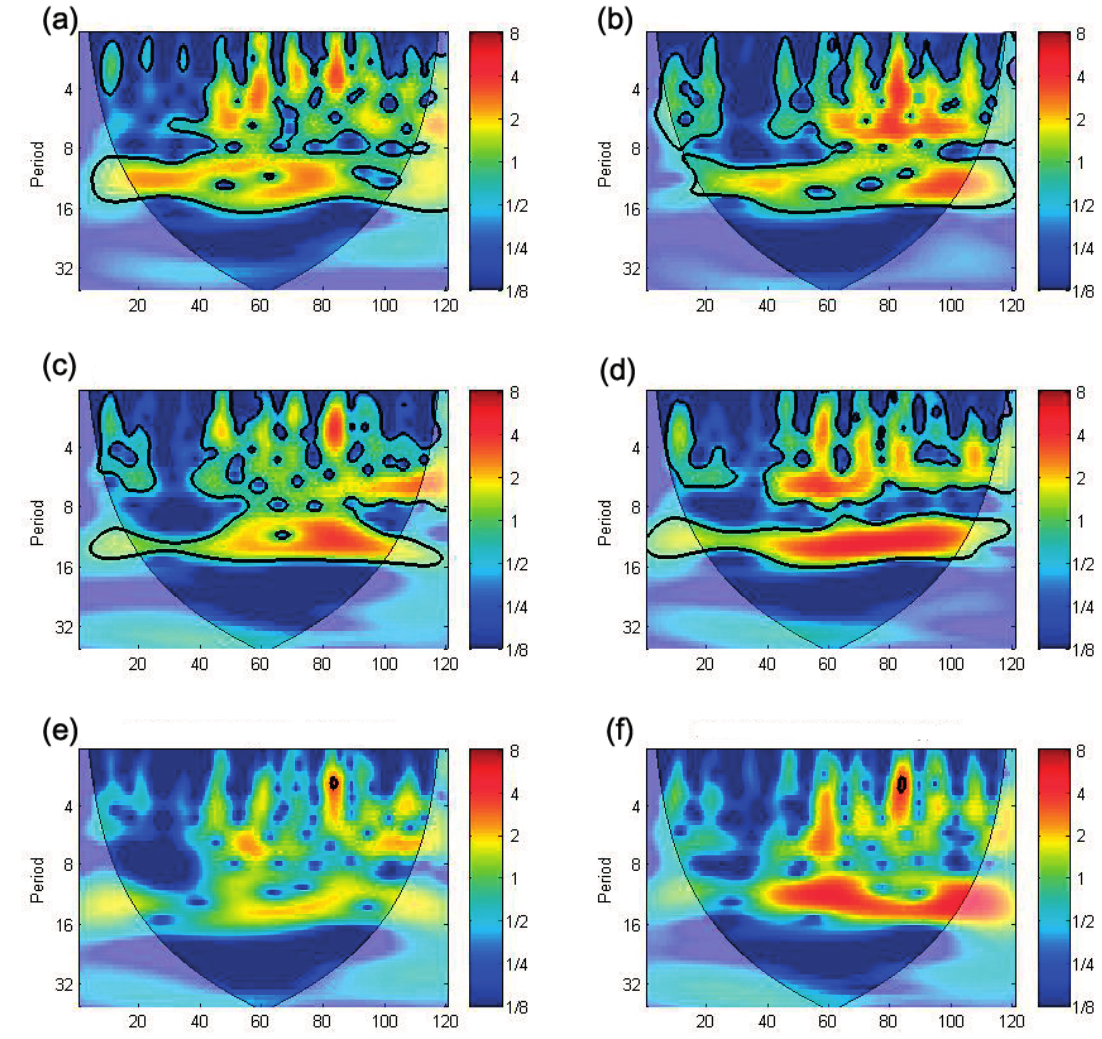
Figure 9. Cross wavelet analysis results between scrub typhus and processed meteorological predictors (removed seasonality): scrub typhus with ( a ) mean temperature; ( b ) precipitation; ( c ) relative humidity; ( d ) wind speed; ( e ) duration of sunshine; and ( f ) cloud amount; bold line indicates 95% confidence inbound which is statistically significant and white transparency area indicates un-confidence area, and blue to red colors indicate the temporal correlation scale with each color-map